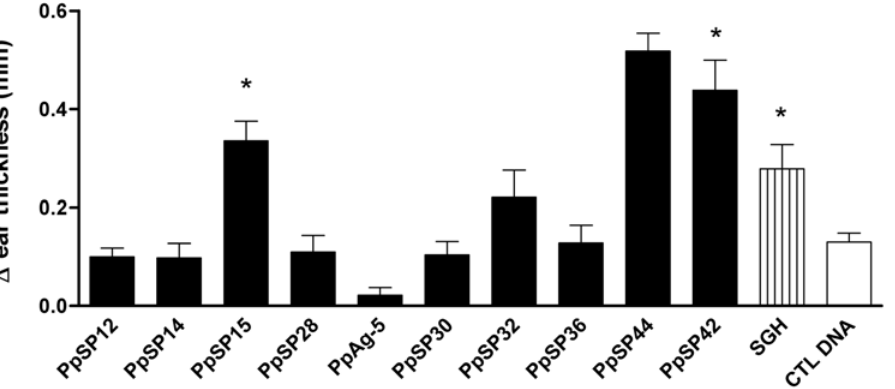
Figure 1. DNA immunization with PpSP15, PpSP42 and PpSP44 induces a DTH response after challenge with SGH. C57BL/6 mice were immunized three times at two week intervals with DNA plasmids coding for ten Phlebotomus papatasi salivary proteins, SGH and CTL DNA in the right ear. Two weeks later the left ear was challenged intradermally with 0.5 pairs of SGH. The DTH response was assessed using D ear thickness (ear thickness of experimental groups subtracted from the mean ear thickness of naı¨ve mice) 48 hours after injection with 0.5 pairs of SGH. Bars represent the mean D ear thickness for 15 mice per group 6 the SEM. Asterisks indicate statistical differences ( p , 0.05) compared to CTL DNA-immunized mice.